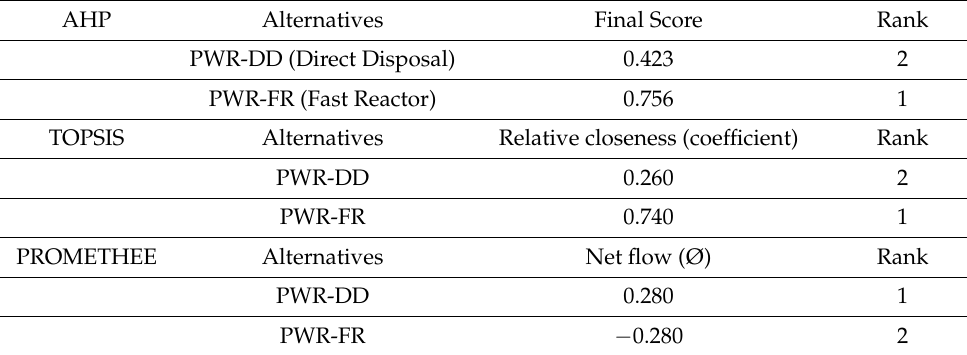
Table 12. MCDM evaluation results.